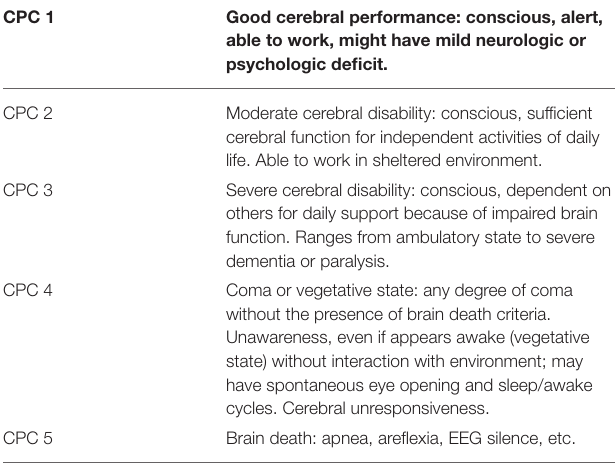
TABLE 1 | Cerebral performance category (CPC) score